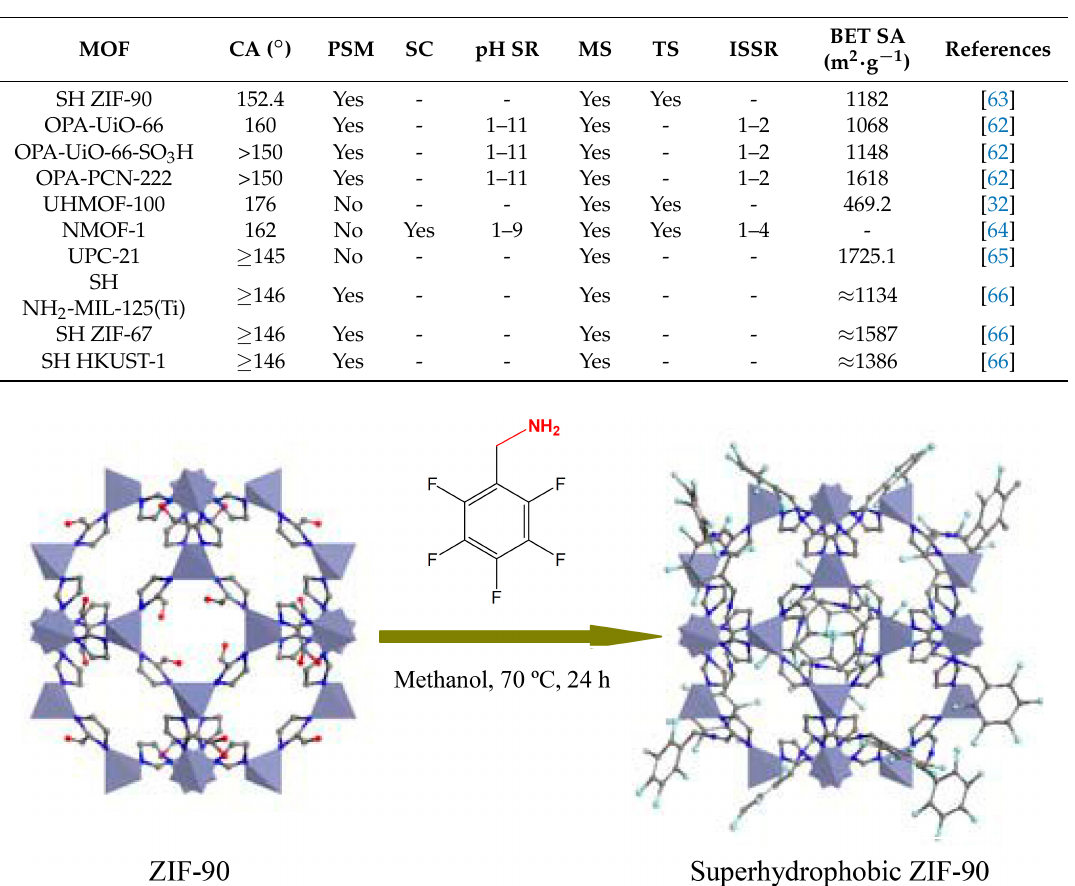
Table 1. Properties of hydrophobic MOFs highlighting contact angle (CA), postsynthetic modification (PSM), SC (self-cleaning), pH stability range (SR), moisture stability (MS), thermal stability, ionic solution stability range (ISSR), Brunauer–Emmett–Teller (BET) surface area (SA) and n-